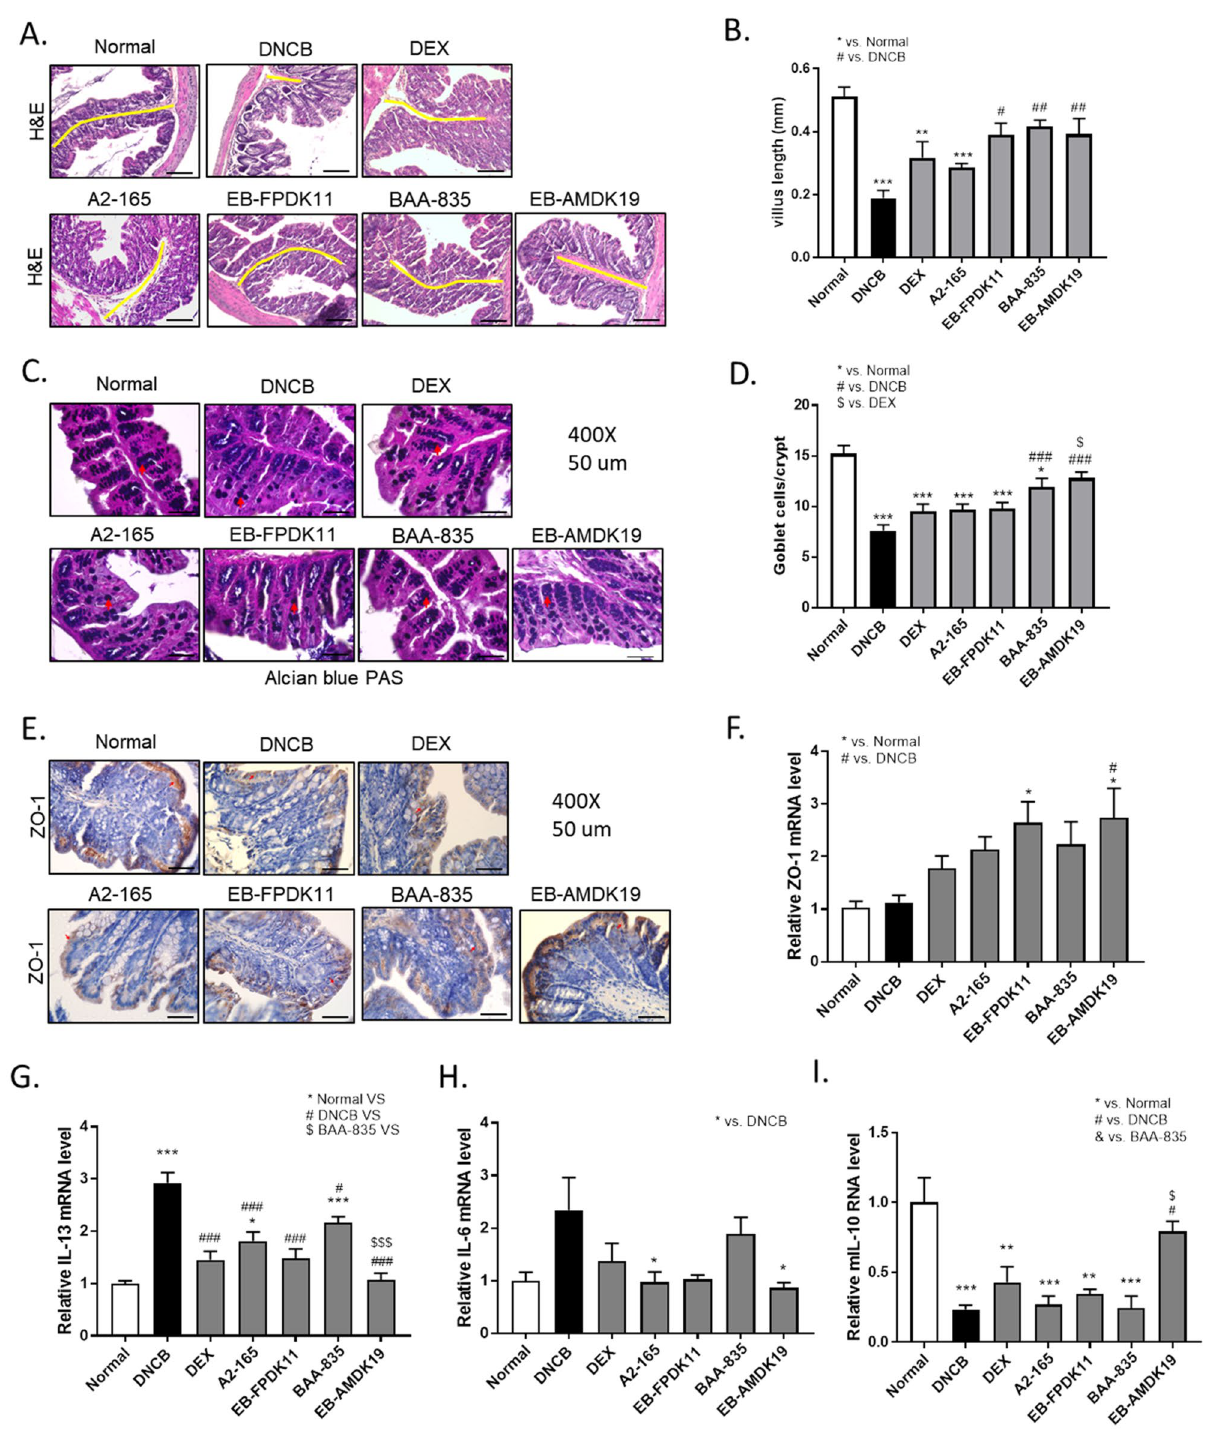
Figure 6. EB-FPDK11 and EB-AMDK19 facilitate intestinal epithelial barrier function maintenance from DNCB-induced colon injury. ( A ) H&E staining of the large intestinal tissues from DNCB-induced AD-like Nc/Nga mice. The yellow lines indicate the villi length. Scale bar, 100 µm. ( B ) Large intestine villi length was determined by measuring vertically well-oriented crypt villi from H&E stained sections. ( C ) Alcian blue PAS staining of the large intestinal tissues, the red arrows indicate positively stained goblet cells. ( D ) Quantitative analysis of the number of goblet cells in the crypt of the colon. ( E ) The expression of ZO-1 proteins in the colon tissue were analyzed using immunohistochemistry staining. Scale bar, 50 µm. ( F ) Relative expression of ZO-1 mRNA expression in the colon tissue was determined by quantitative PCR. ( G – I ) Transcript levels of Th2 related cytokine genes, mIL-13 ( G ), mIL-6 ( H ), and mIL-10 ( I ) were determined by quantitative PCR. Data are presented as mean ± SEM of changes in values. * P < 0.05, ** P < 0.01, *** P < 0.001; *versus normal group; # versus DNCB group; $ versus DEX group; & versus BAA-835